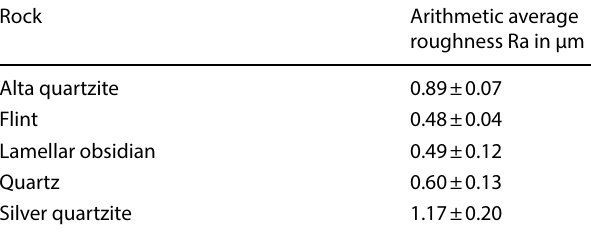
Table 1 Roughness of the samples for hardness measurements and 3-point bending tests after grinding